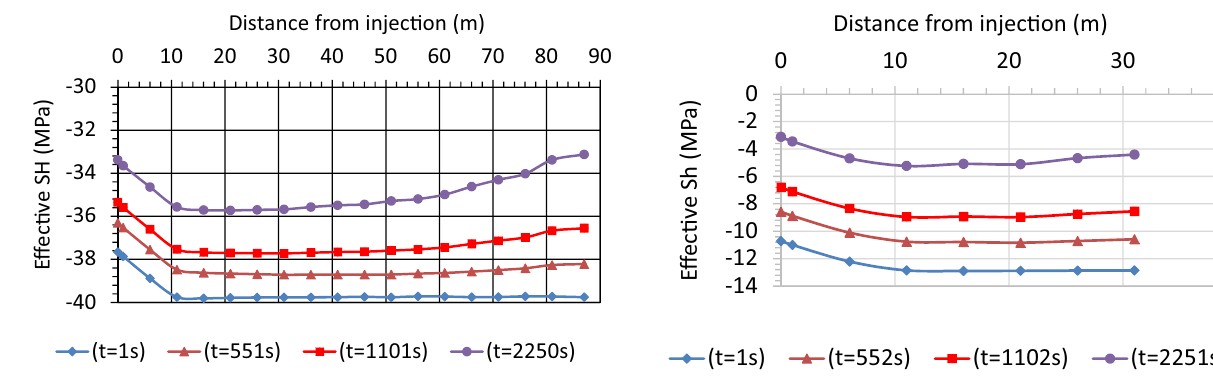
Fig. 6 Case 1 ( k = 23.4 mD): Effective minimum horizontal stress versus distance along SRV width from the injection port at different injection times